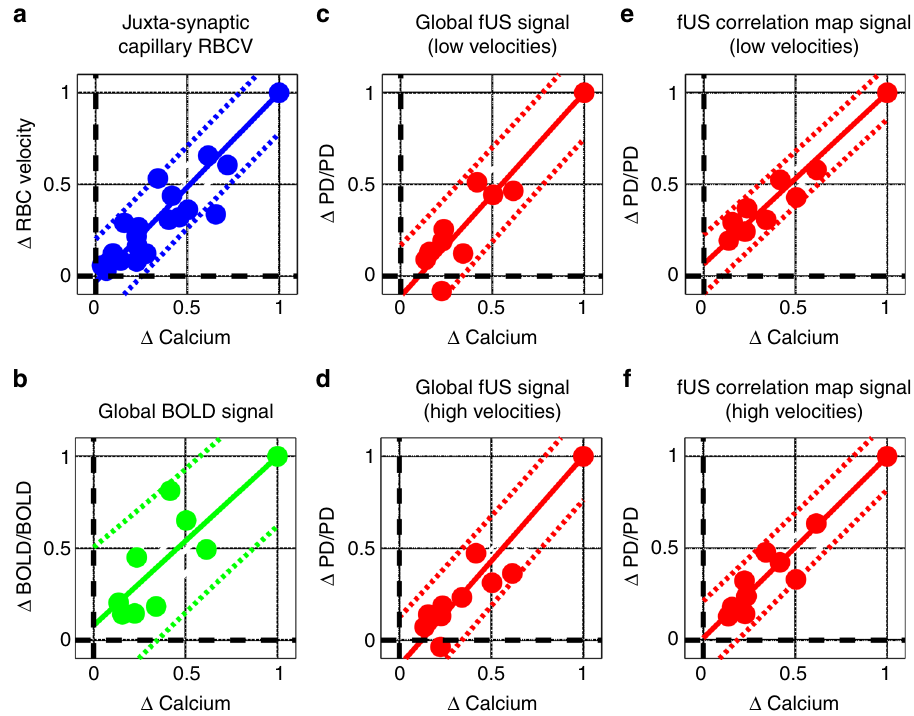
Fig. 7 Correlation of glomerular Ca 2 + with juxta-synaptic capillary and mesoscopic vascular signals. All vascular signals (both local and mesoscopic) are linearly related to glomerular Ca 2 + increases over the range of odour concentrations tested. Integrals (AUC) of the signals are plotted on both axes, normalized to the response at the highest odour concentration (35% ET). a Simultaneous RBC velocity and postsynaptic Ca 2 + responses at increasing odour concentration. b Global Δ BOLD/BOLD responses measured within the mask of the entire OB slice vs. Δ Ca 2 + . c , d Global Δ fUS/fUS signal measured within the mask of the entire OB slice vs. Δ Ca 2 + . The fUS signals are fi ltered to show responses from vessels with axial velocity between 0.5 and 1.5 mm/s ( c ) or > 4 mm/s ( d ). e , f Δ fUS/fUS responses comprising from all the voxels signi fi cantly correlated to the RBC response (see Fig. 5c as an example). Data points in each plot are responses to a range of odour concentrations from different mice ( n = 5 mice in a , three mice in plots b – f ). Dashed lines indicate 95% con fi dence level of the fi t. Fits from individual mice are included in Supplementary Figure